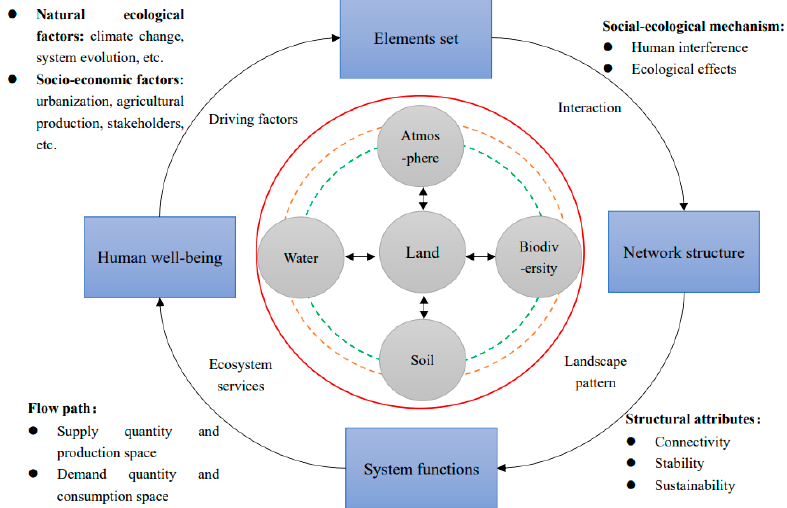
Figure 10. Optimization conceptual model of spatial pattern of land use based on ENSH.